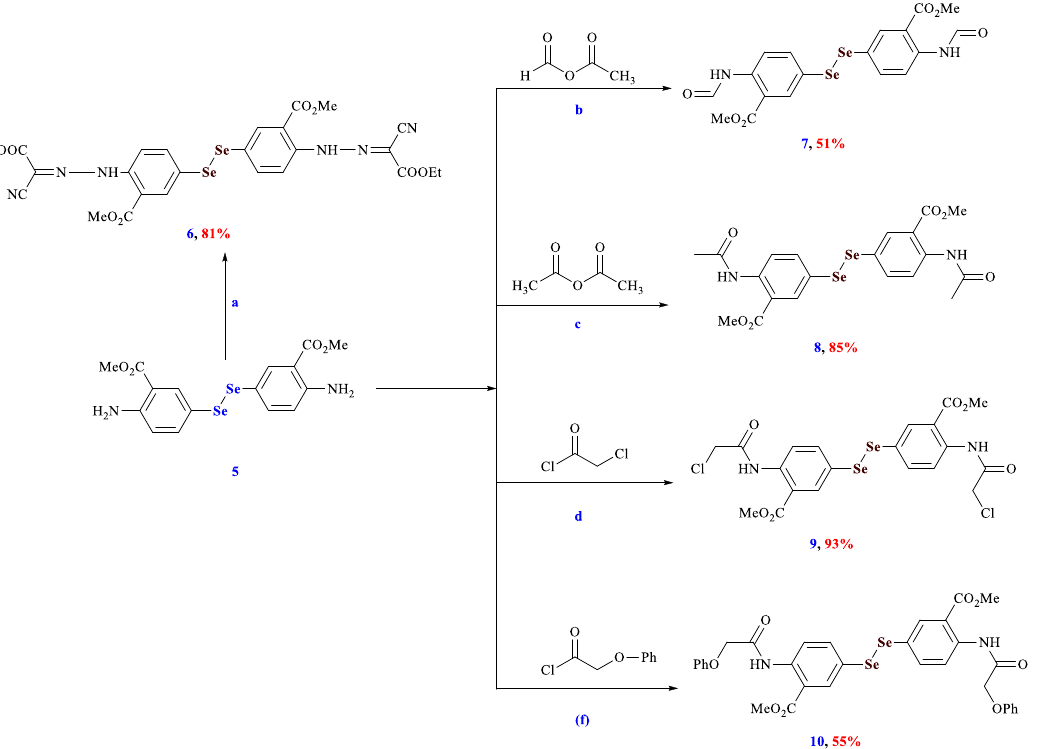
Scheme 2. Synthesis of diselenides 6 , 7 , 8 , 9 , and 10 . Reagents and conditions: (a) compound 5